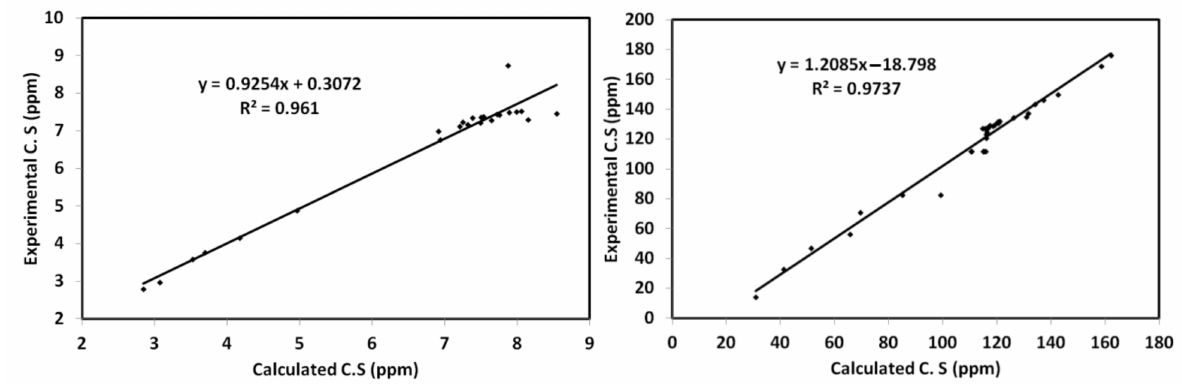
Figure 12. 1 H and 13 C NMR correlations between the calculated and experimental